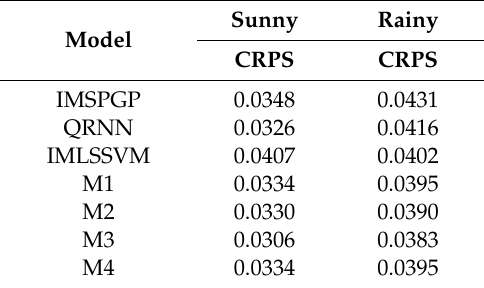
Table 7. CRPS of various combinations.